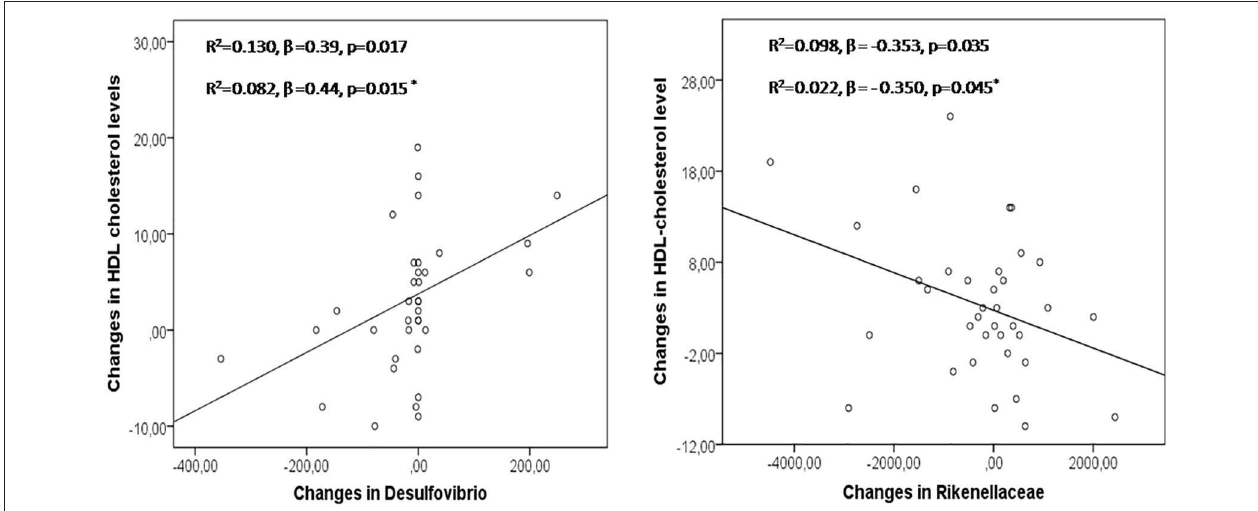
FIGURE 2 | Changes in Desulfovibrio and Rikenellaceae in the prediction of modifications in HDL levels after H pylori eradication treatment. Asterisk: linear regression model adjusted by age, sex, and BMI.